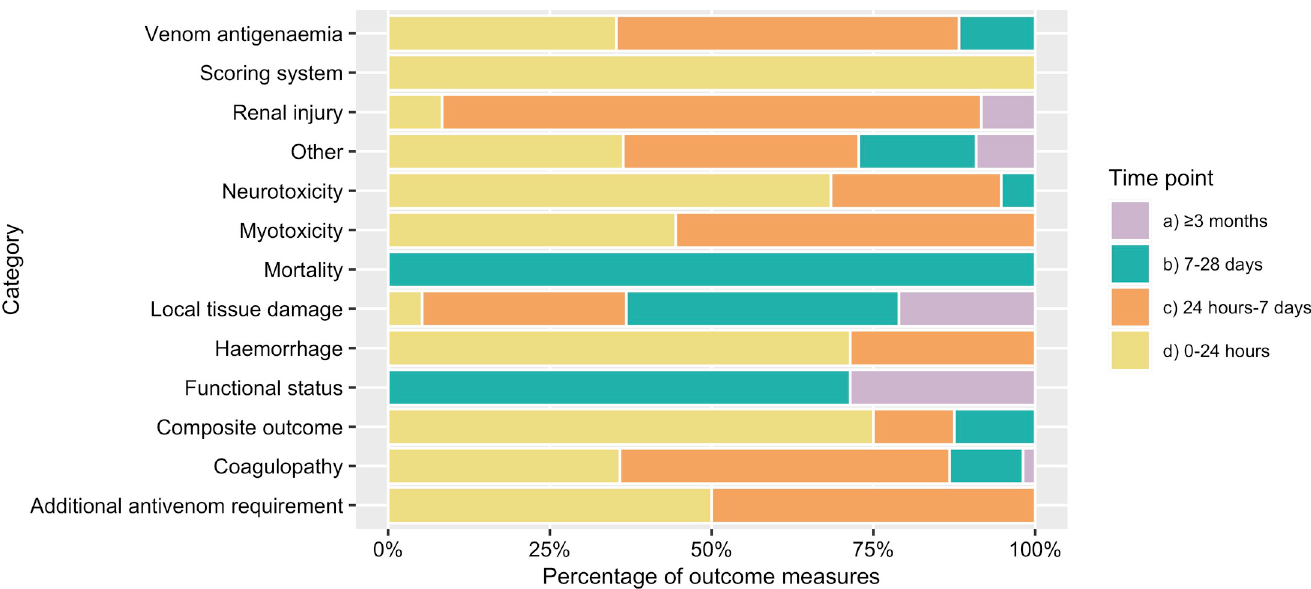
Fig 4. Duration of follow-up of outcome measures: grouped by category of envenoming. Fig 4 depicts the time-period of follow-up of outcome measures within each category. For each outcome measure, the latest time point of follow-up was identified. Time points were grouped as: up to 24 hours; up to 7 days; up to 28 days; up to 3 months; and over 3 months. Within each category, the proportion of outcome measures with follow-up until each time-point is defined. For example, mortality outcome measures were always followed up for over 7 days but were never followed up for more than 28 days. No outcome measures were followed up until between 28 days and 3 months, and therefore this time point is not displayed in Fig